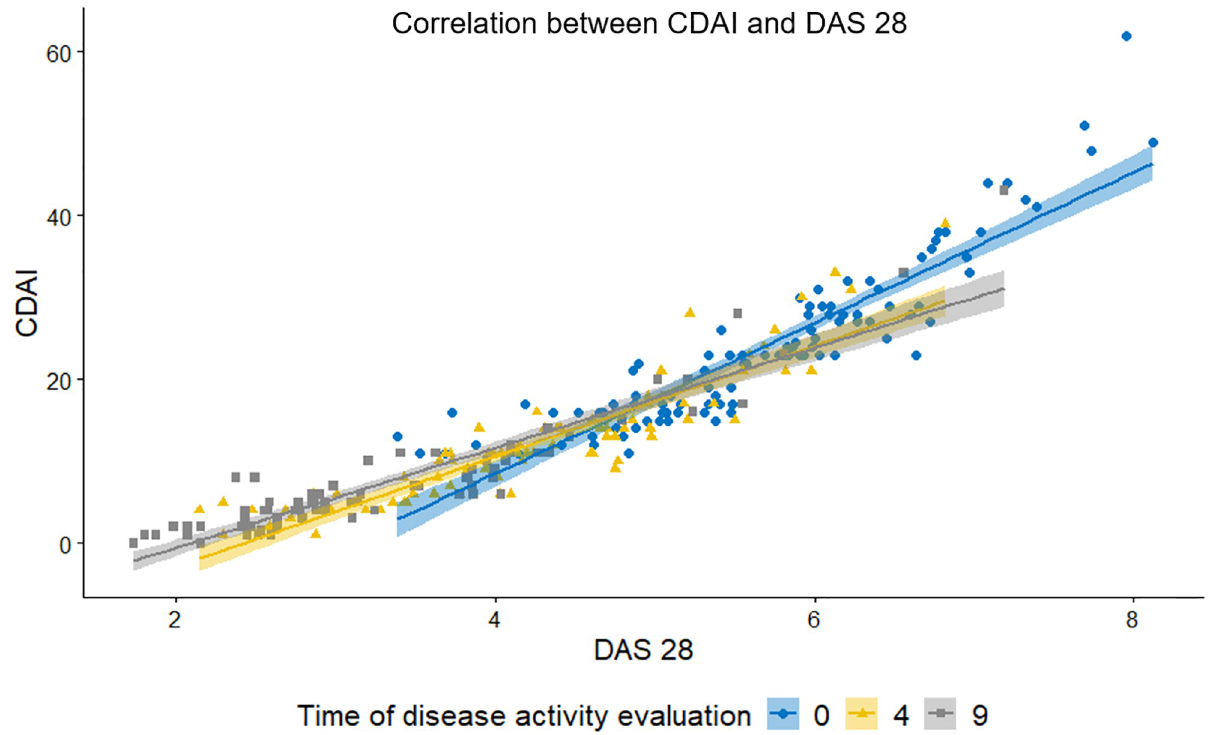
Fig 2. Scatter plot illustrating linear positive correlation between DAS 28 and CDAI assessed at 3 time points (0 = 0 months, 4 = 4 months, 9 = 9 months). At all three time points of evaluation, CDAI was strongly correlated with DAS 28; ρ = 0.9357 at 0 months (p < 0.05), ρ = 0.9354 at 4 months (p < 0.05), ρ = 0.9106 at 9 months (p < 0.05). CDAI–clinical disease activity, DAS 28- disease activity score 28.